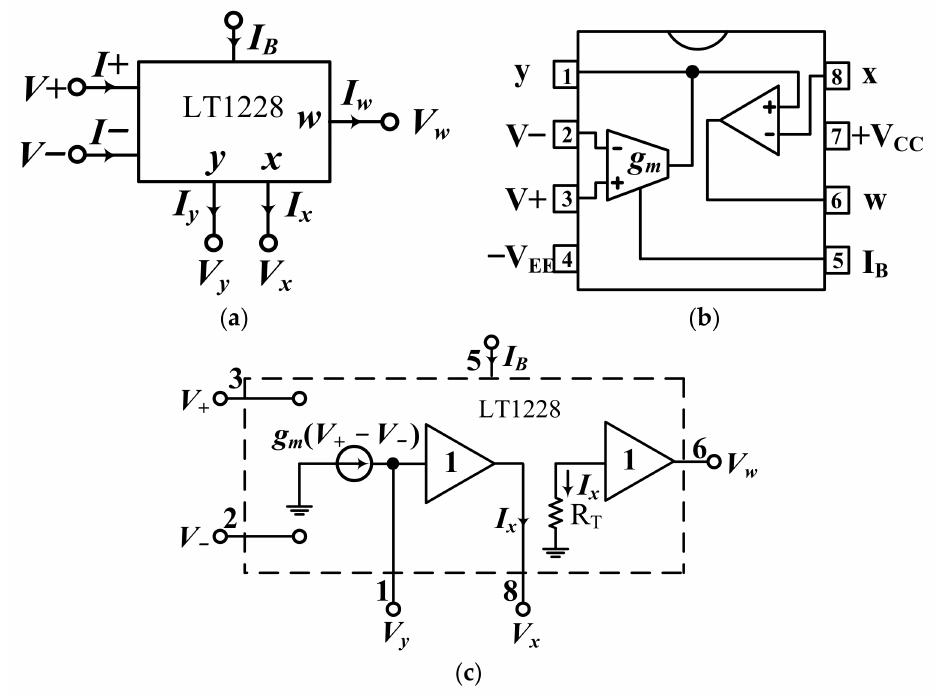
Figure 1. LT1228. ( a ) Schematic symbol. ( b ) Pin. ( c ) Equivalent